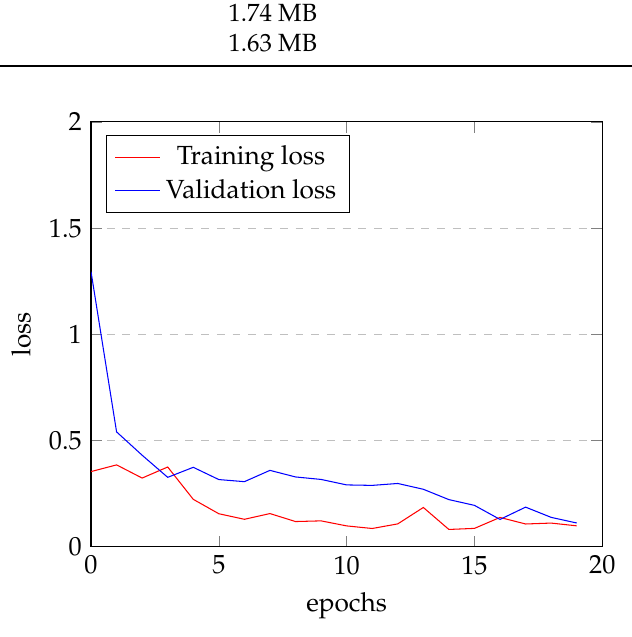
Figure 11. Training and validation losses for the pruned